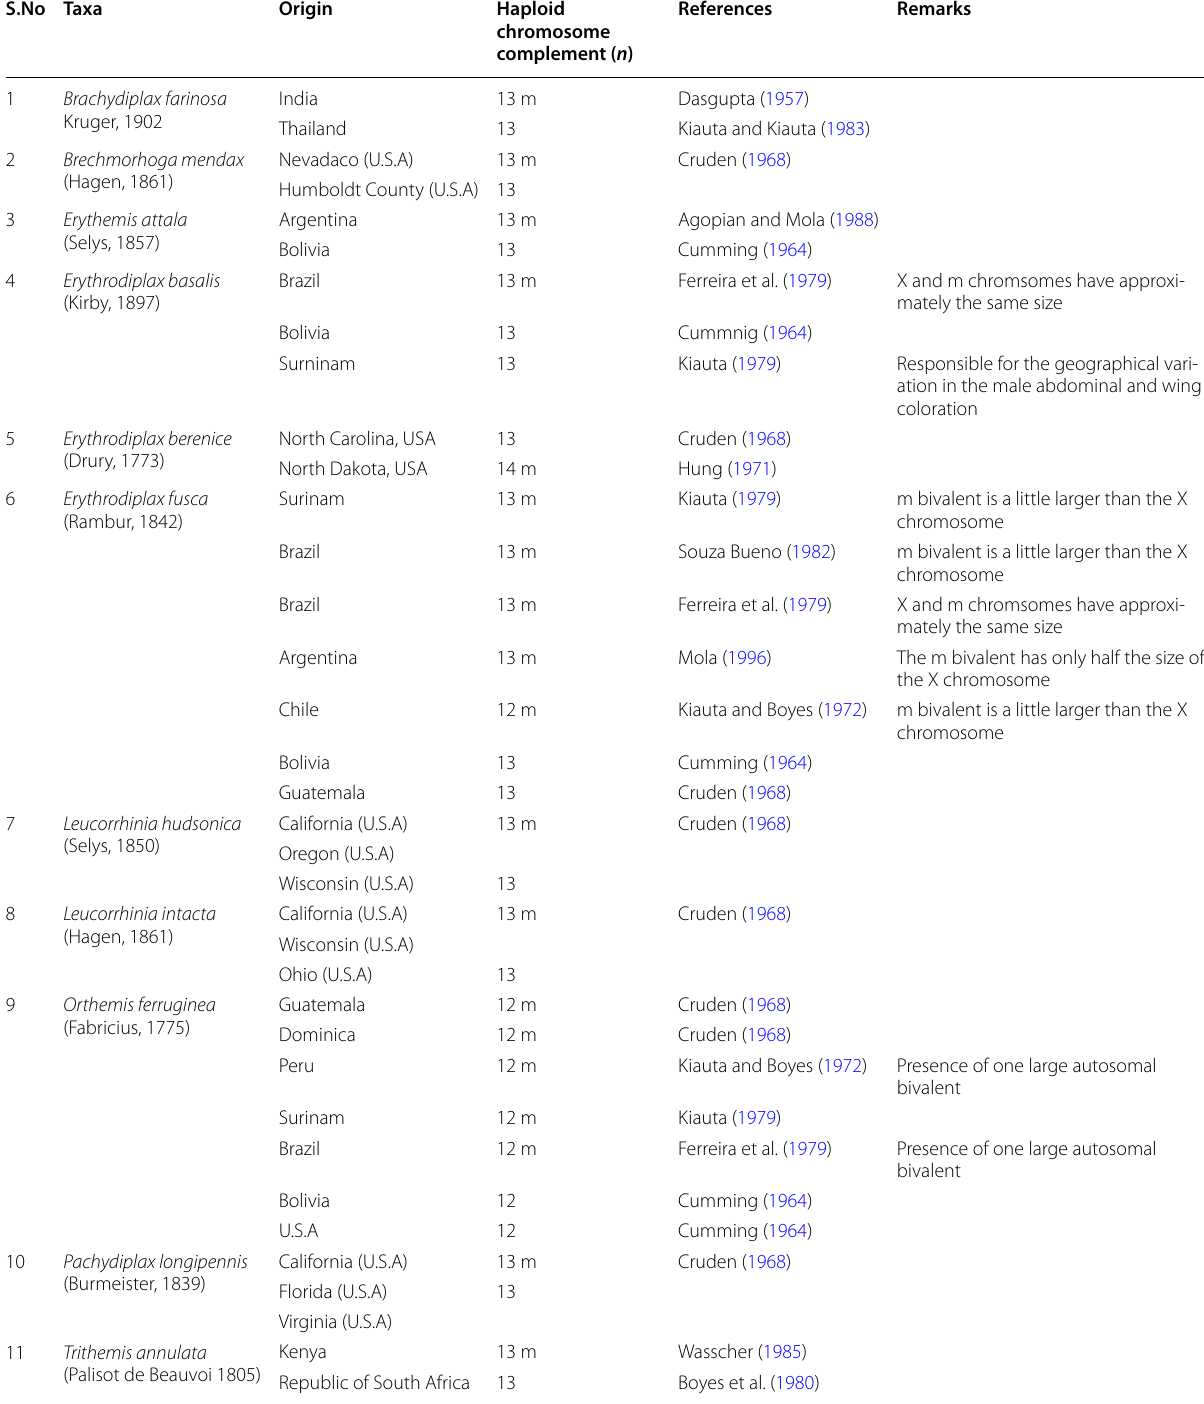
Table 2 Presence/absence of m chromosomes in different geographical populations of the species S.No